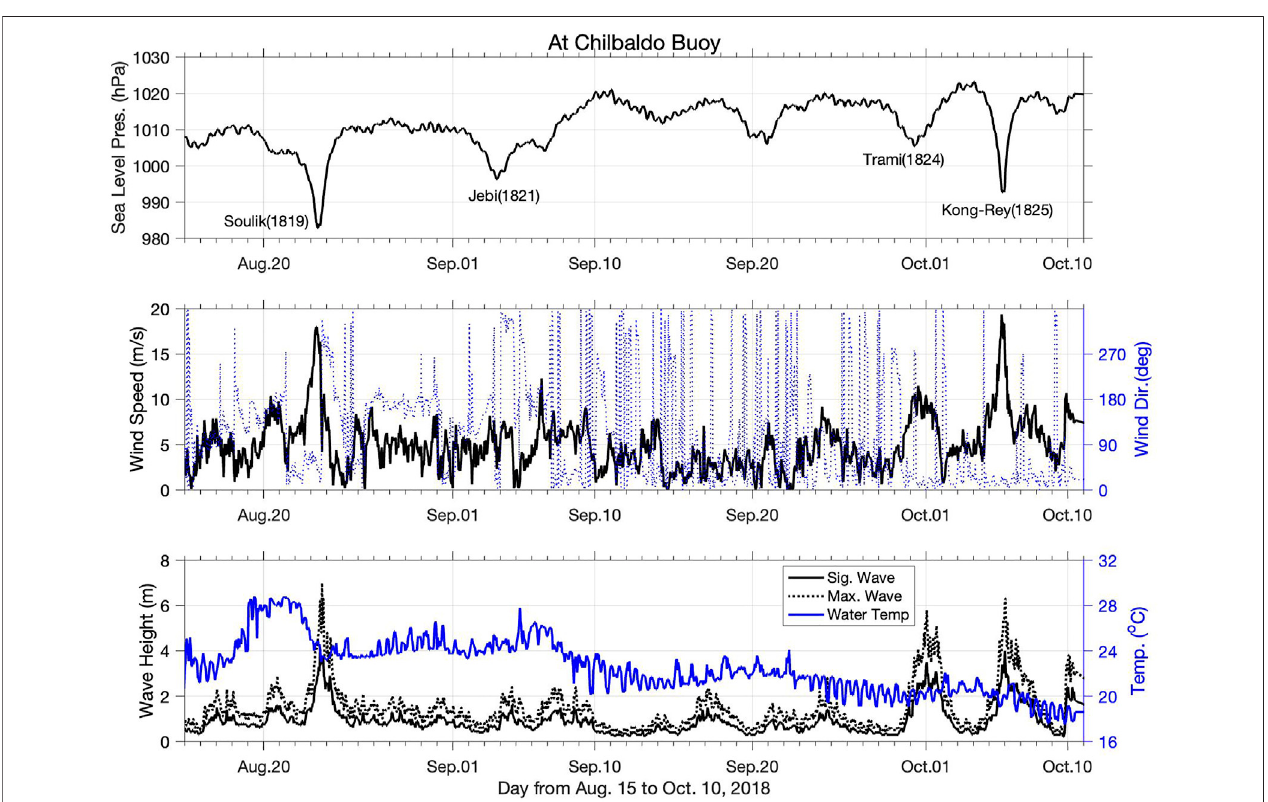
FIGURE 2 | Time series of sea level pressure, wind speeds and direction, and wave height and water temperature obtained by the Chilbaldo buoy station from August 15 to October 10, 2018. Time is in UTC units.